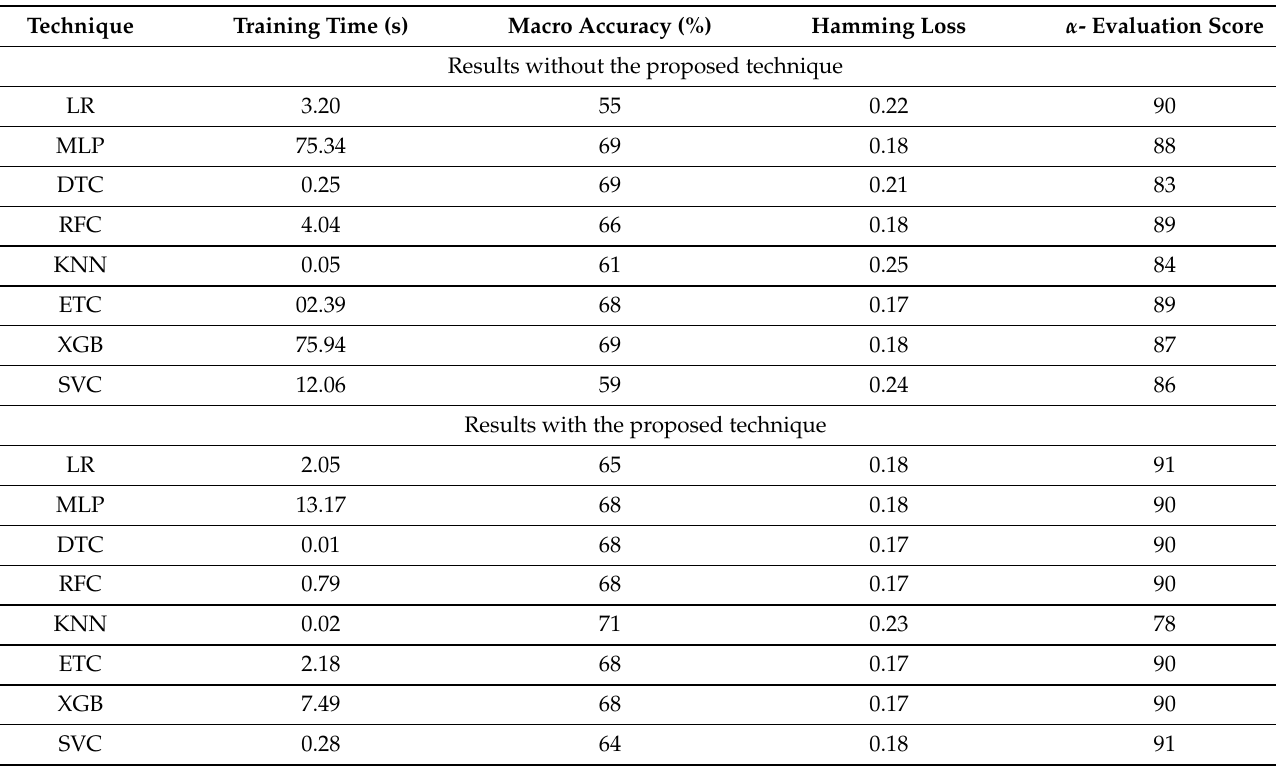
Table 5. The multi-label multi-class performance comparative analysis with an imbalanced dataset using a data split of 70:30.